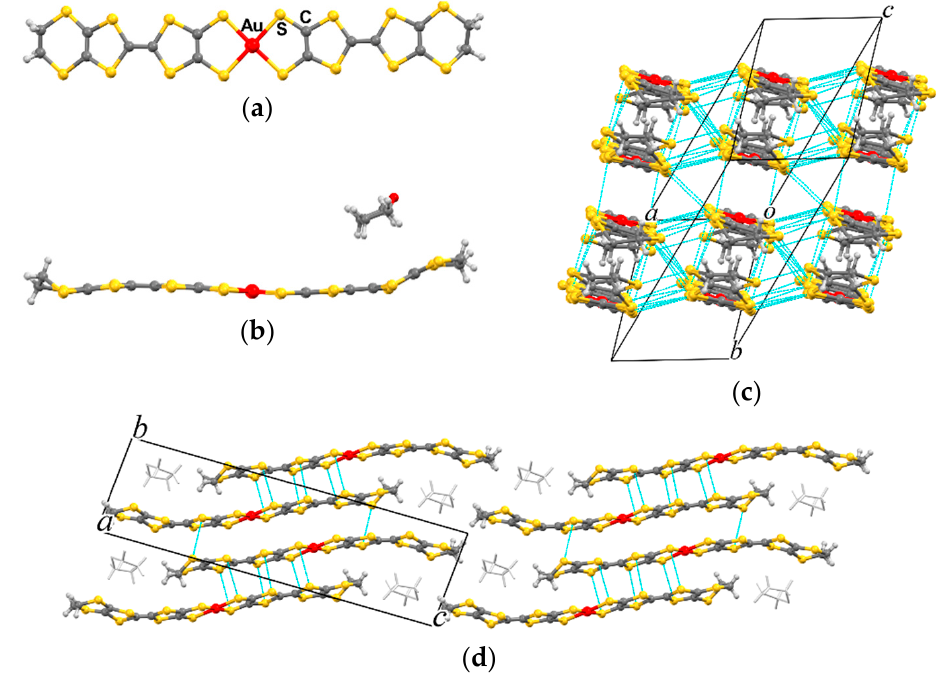
Figure 2. ( a ) Top view of the neutral [Au(etdt) 2 ] molecule without THF molecule. ( b ) Side view of the neutral [Au(etdt) 2 ] molecule with THF molecule. ( c ) Crystal structure of 2 viewed along the long axes of molecules. The short S ··· S contacts ( < 3.7 Å) are shown as dotted line. THF molecules are omitted for clarity. ( d ) Crystal structure of 2 viewed along the a -axis.